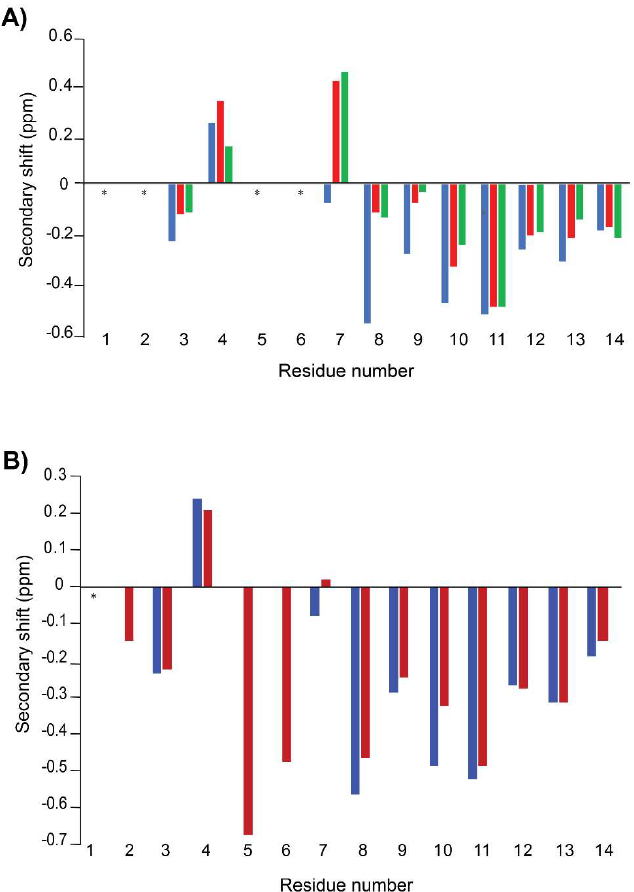
Figure 2. Secondary shift analysis. The secondary shifts were calculated by subtracting the random coil shifts [22] from the αH shifts. ( A ) MC12-linaclotide (blue), Linaclotide (red), and STh (6-19) (green); ( B ) Comparison of secondary shifts of MC12-linaclotide derived from spectra recorded in aqueous solution (blue) and 100 mM SDS (red). Residues that were not able to be assigned are marked with an asterisk.